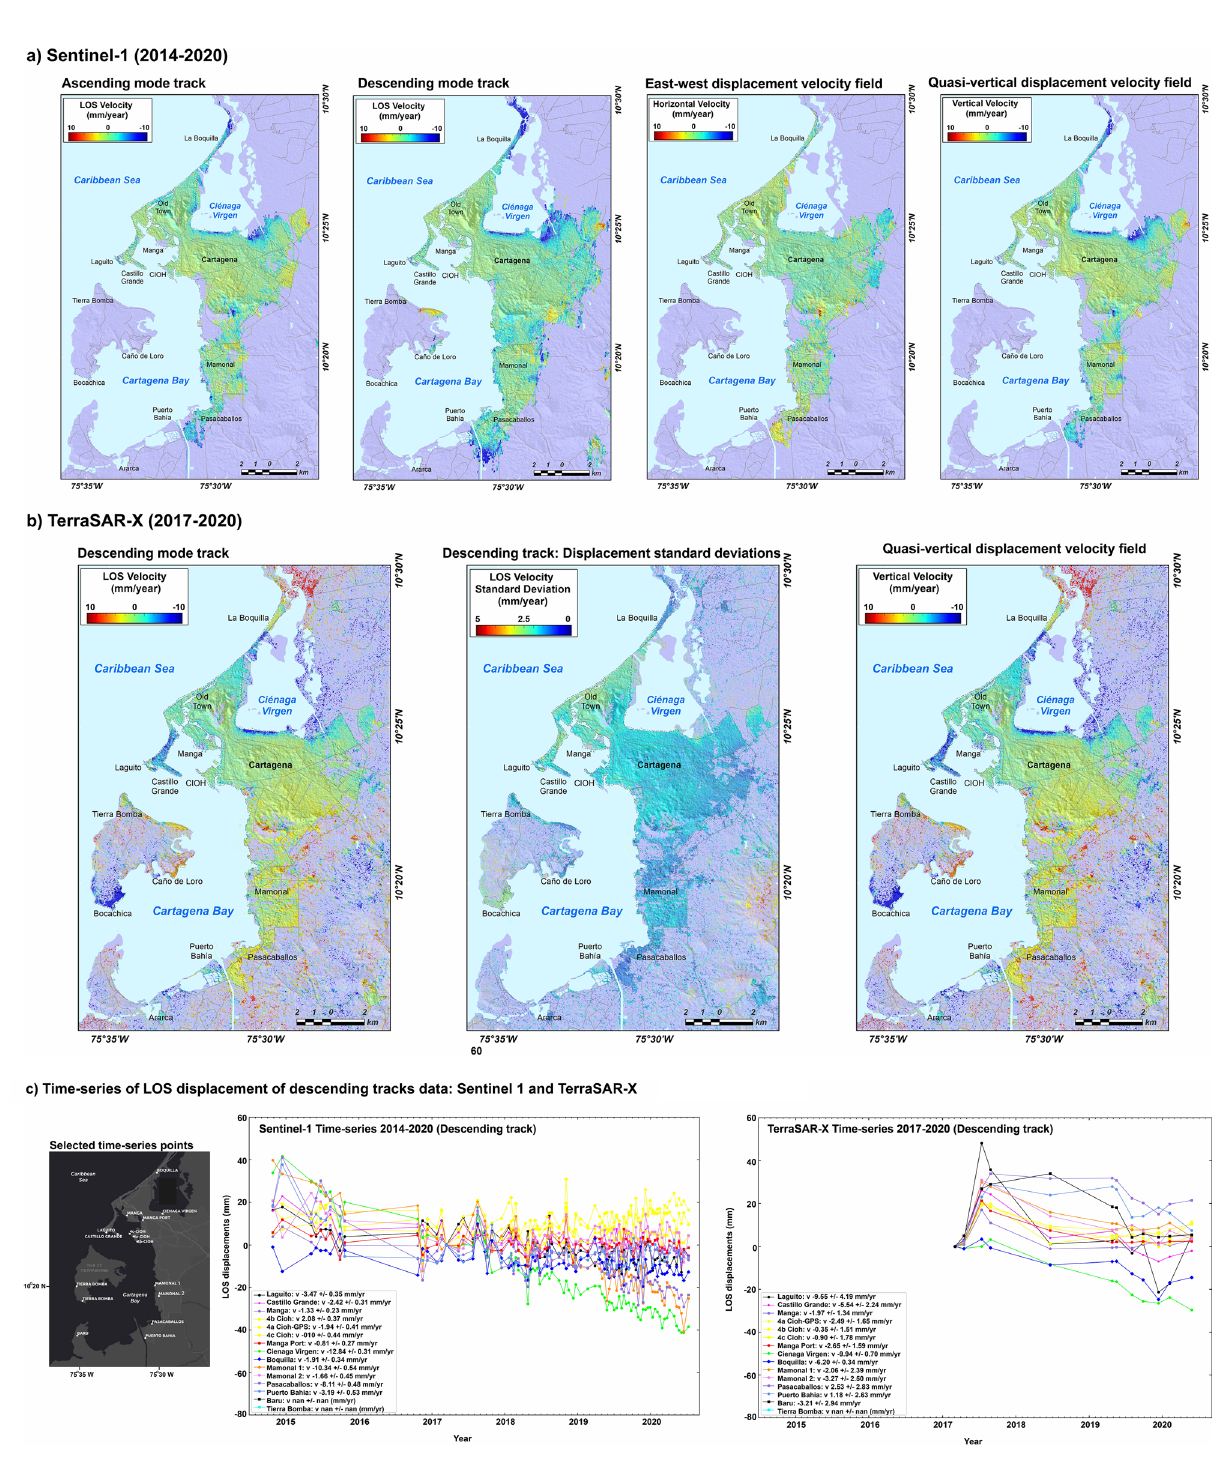
Figure 4. ( a – c ) Quantitative estimation of quasi-vertical displacements using Interferometric Synthetic Aperture Radar (InSAR) techniques. ( a ) Sentinel-1 images (2014–2020), showing ascending and descending mode tracks, and vertical and east–west displacement velocity fields. ( b ) TerraSAR-X image of descending mode track (left) and its standard deviations (center), and map of vertical displacement velocity field during the 2017–2020 period (right). ( c ) Time series of LOS displacements (mm/yr) at selected sites in the coastal zone of Cartagena. InSAR maps generated by open-source Python 3.8 using matplotlib module version